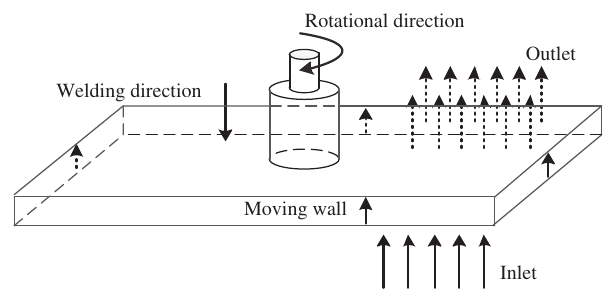
Figure 3: Geometric model of the plunging stage.